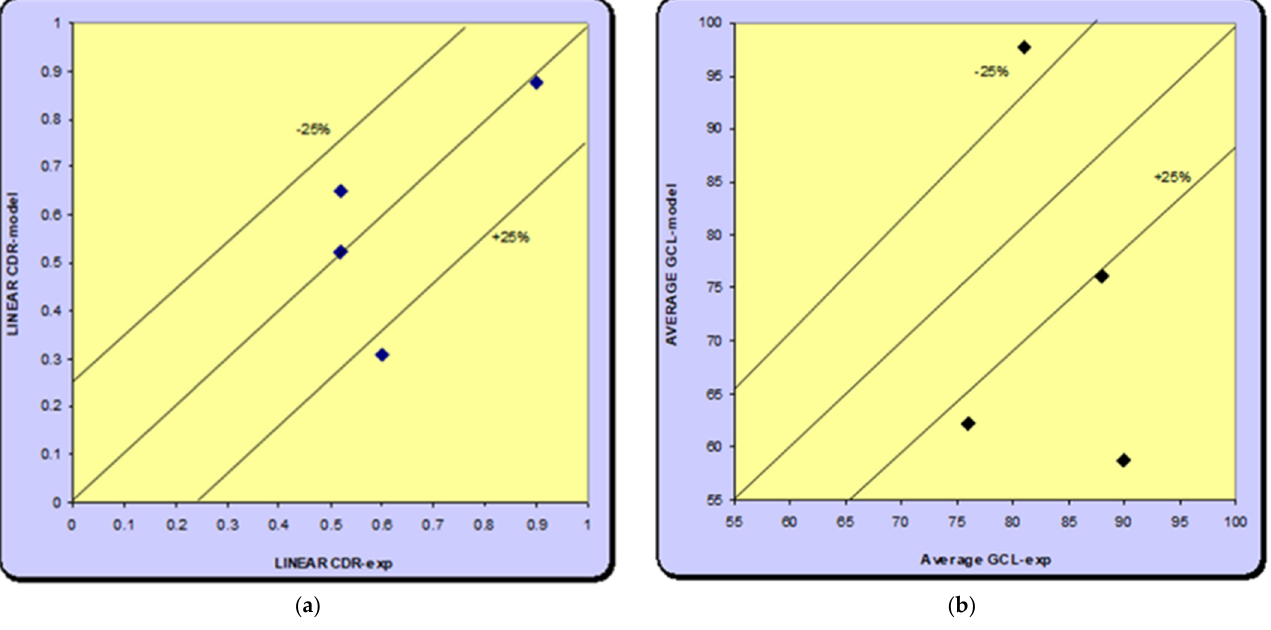
Figure 8. Comparison of experimental results with those provided by the ANN network (21:35:4) for ( a , b ) predictions (C/D, experimental average GCL).